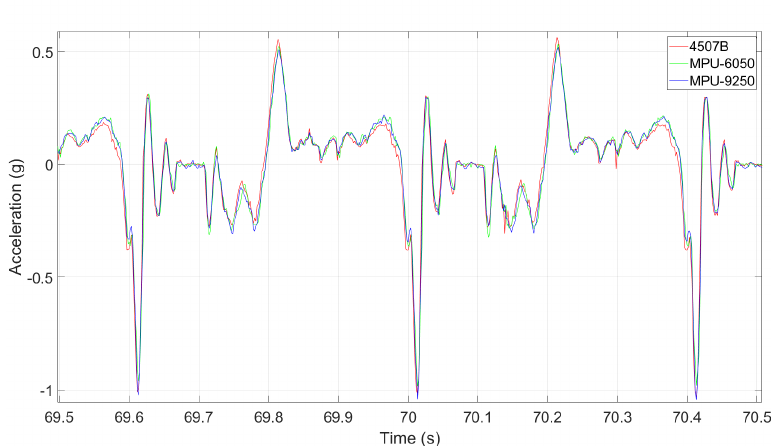
Figure 12. Responses in the time domain using the modulated shaker at 2,5